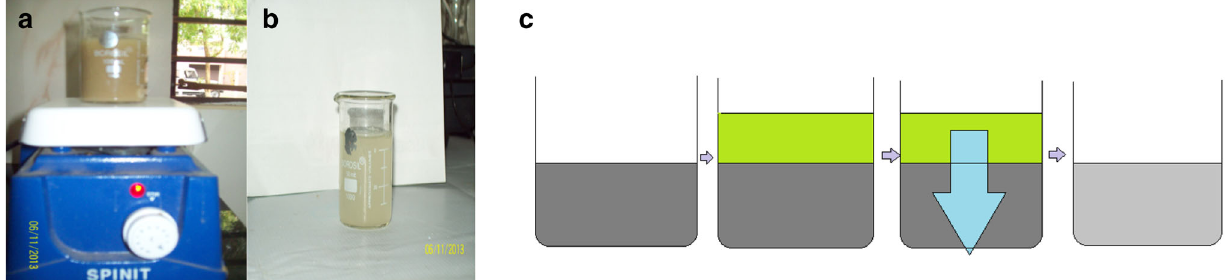
Fig. 1 a Preparation of Moringa extract, b Moringa extract, c preparation of MOCP